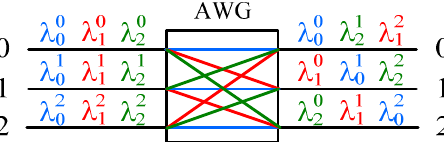
Figure 1. Nine signals can pass through a 3 × 3 arrayed waveguide grating (AWG) simultaneously by using three different wavelengths {0, 1, 2}. In the notation λ wi , w refers to the wavelength and i refers to the input port